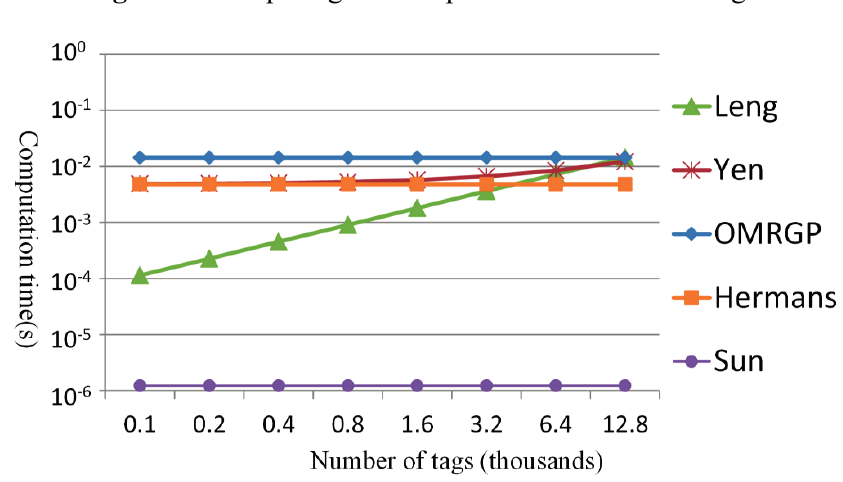
Figure 9. Comparing the computational load of